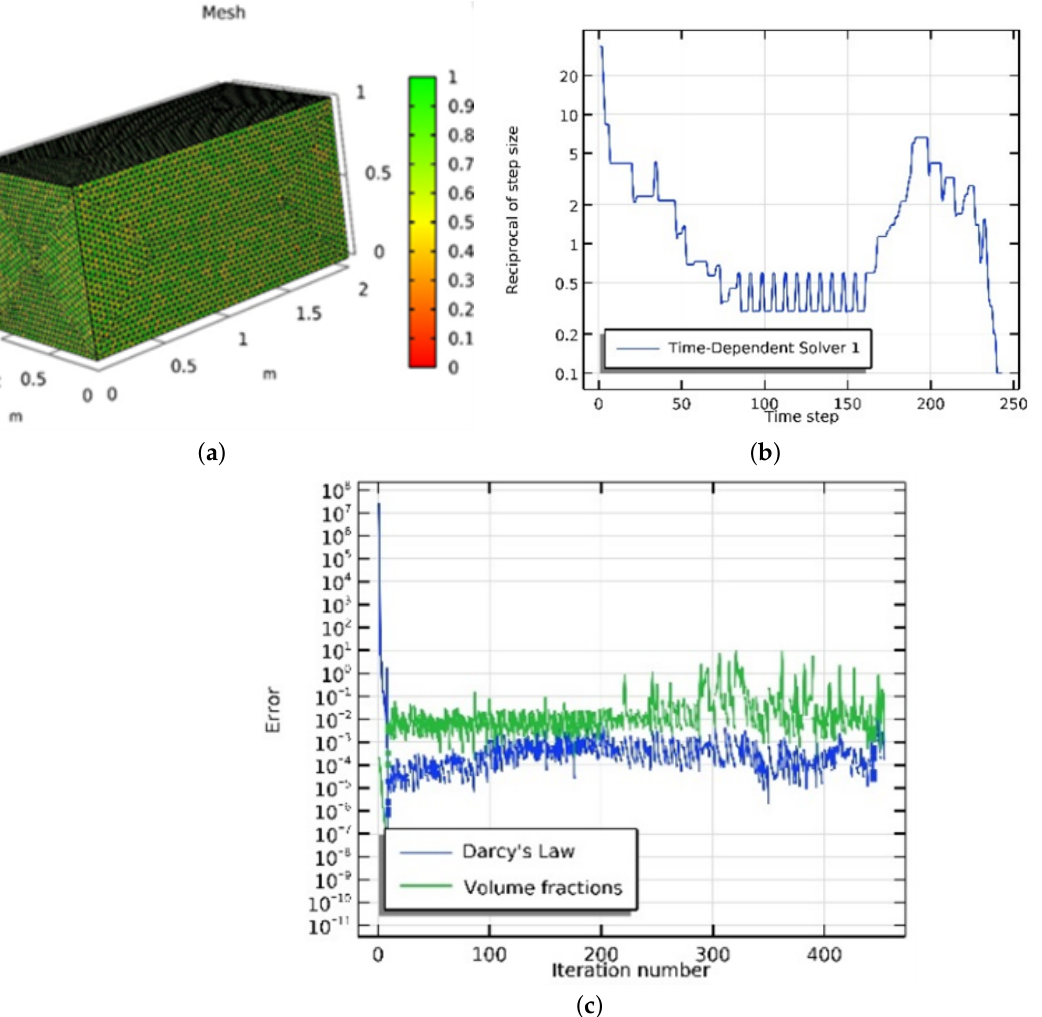
Figure 4. ( a ) Inspection of the mesh, ( b ) convergence plot, and ( c ) the error less than 1 × 10 − 5